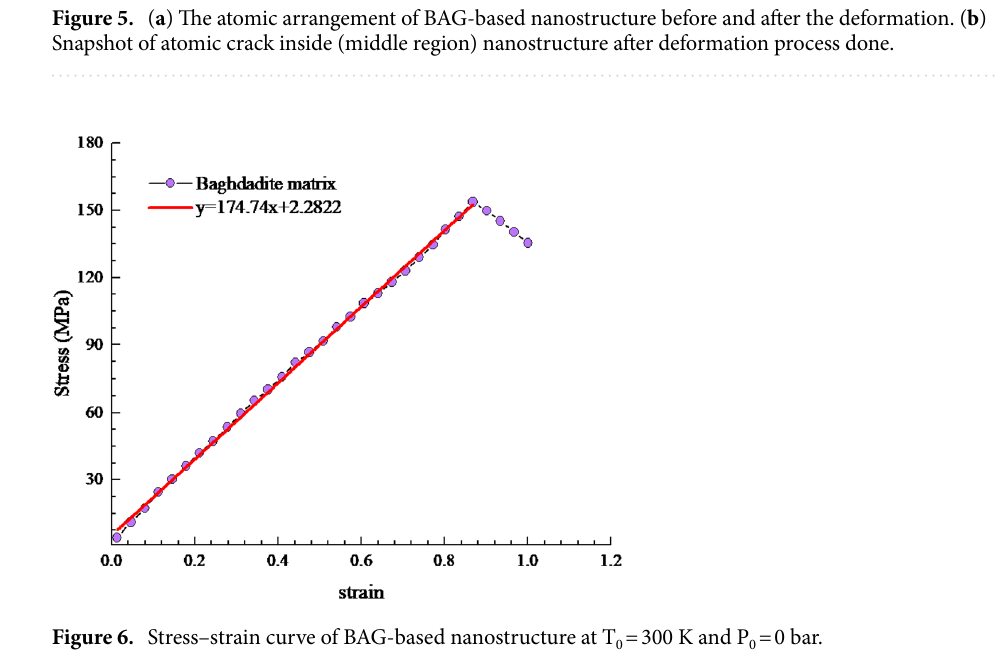
Figure 6. Stress–strain curve of BAG-based nanostructure at T 0 = 300 K and P 0 = 0